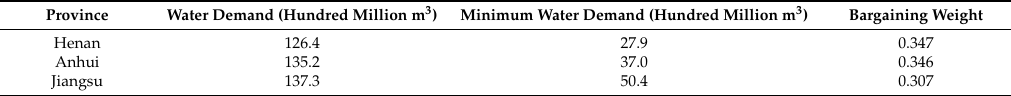
Table 4. The bargaining weights under the equity principle.